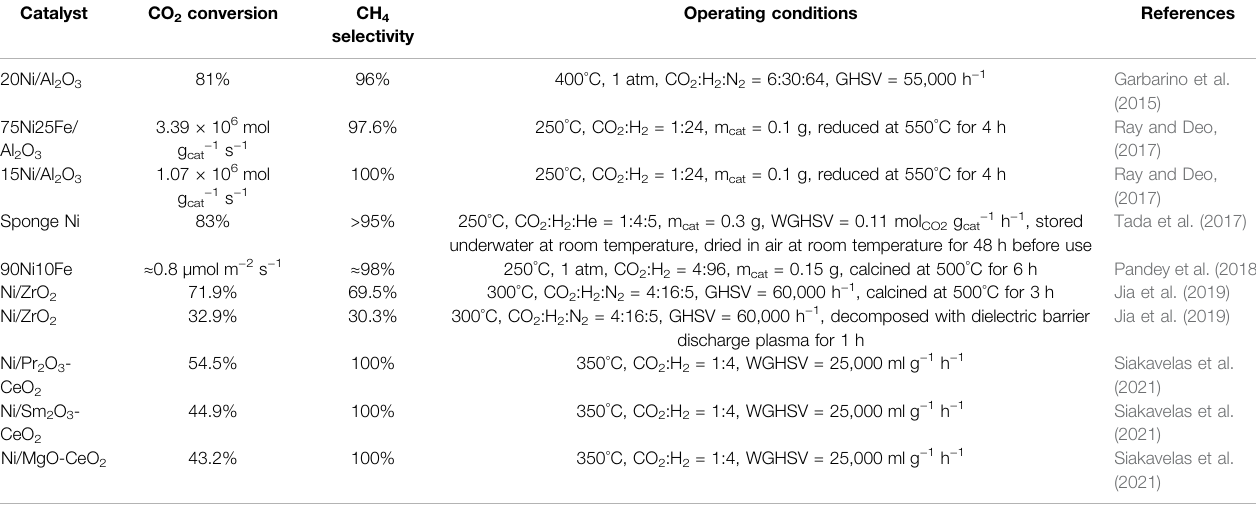
TABLE 1 | Performance comparison of different nickel (Ni)-based catalysts in CO 2 methanation. Catalyst